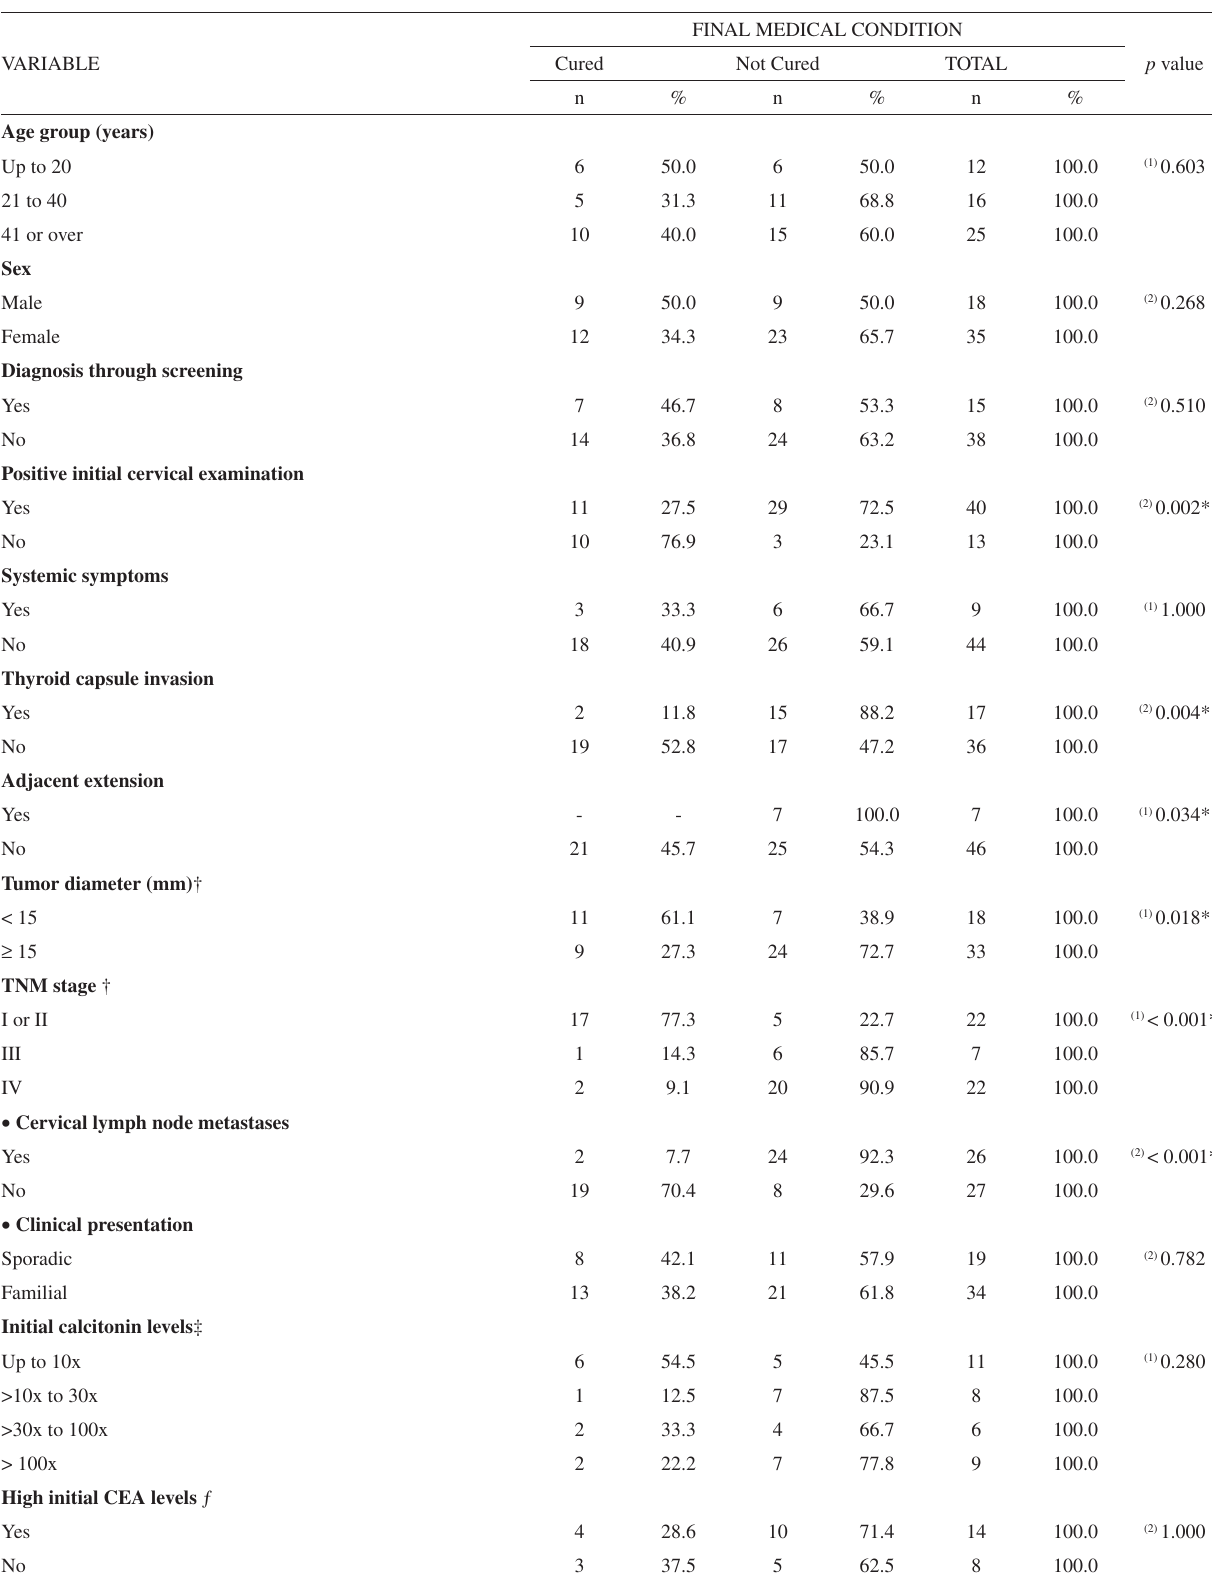
Table 1 - Correlation of final medical condition with clinical and pathological variables